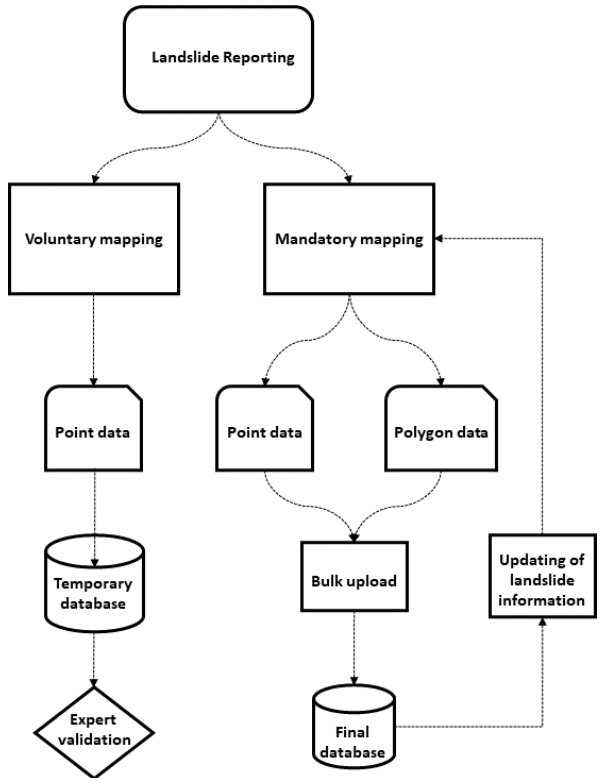
Figure 3. The workflow for reporting